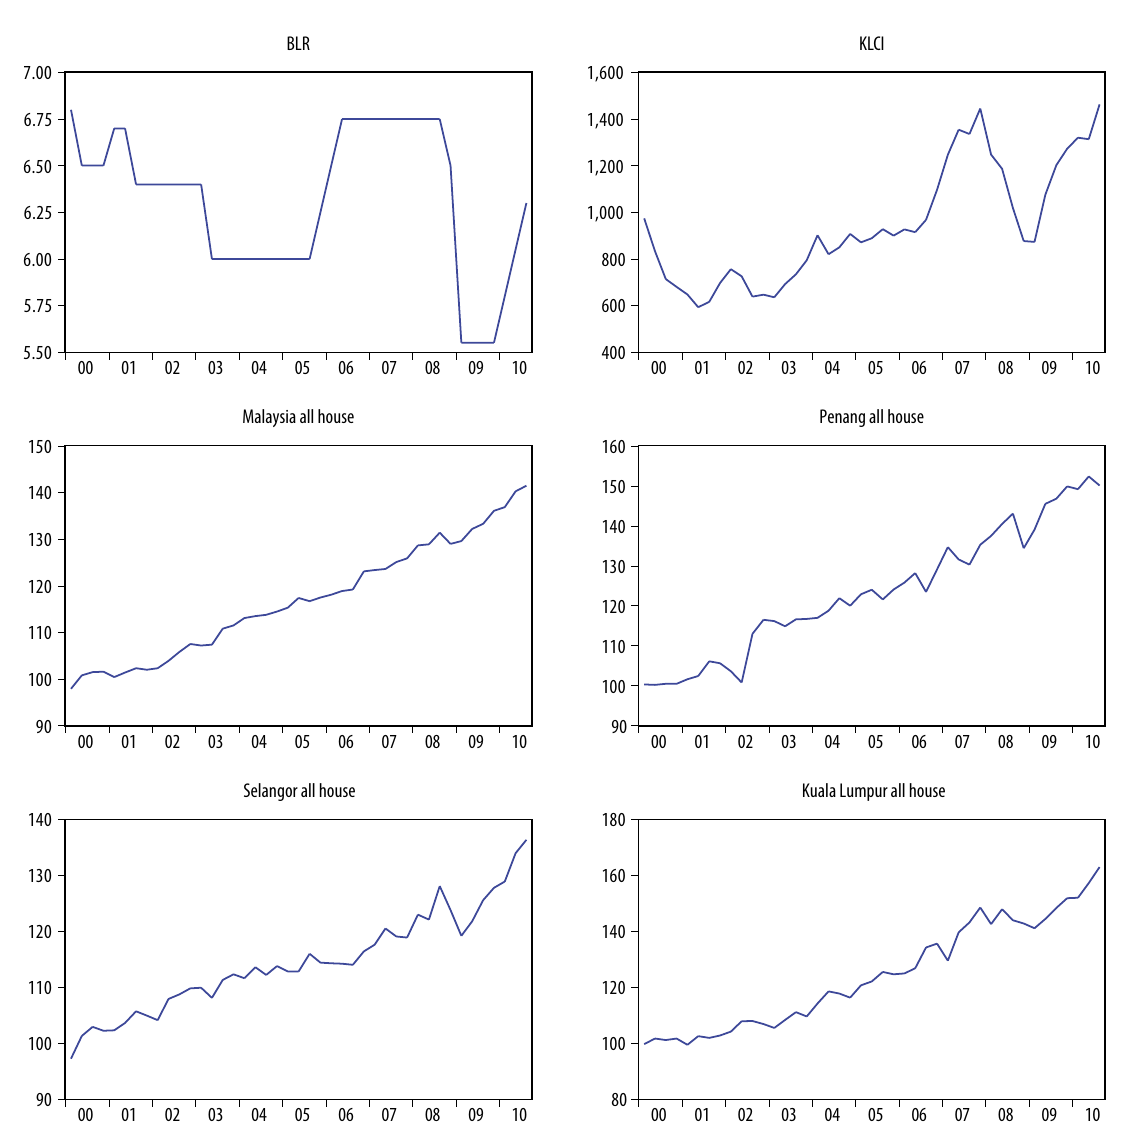
Fig. 1. Time series plots for interest rate, stock prices and house